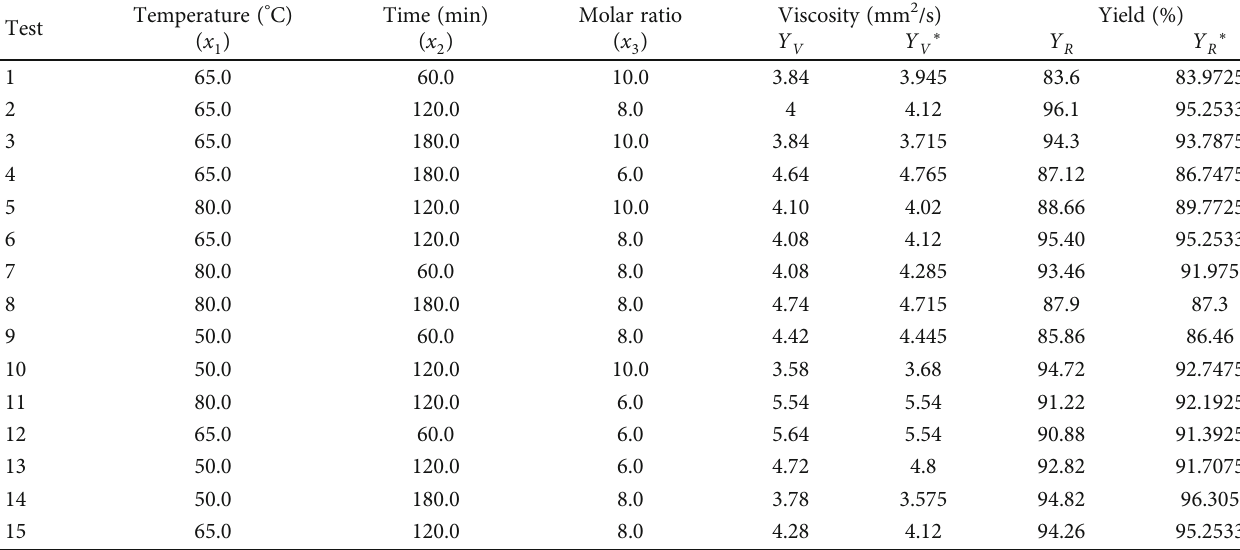
Table 2: Experimental matrix and theoretical experiments and responses.